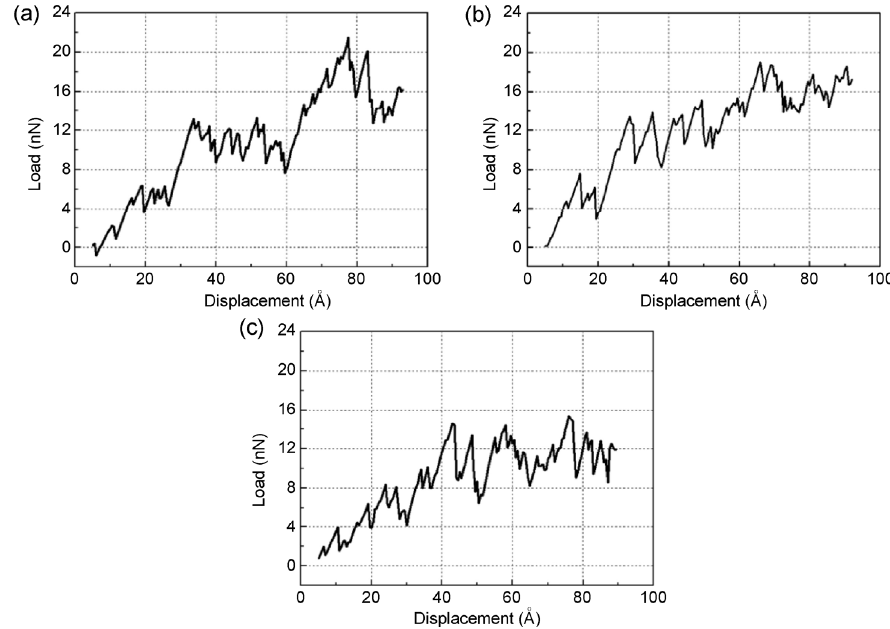
Fig. 10 Load–displacement plots with particle radius of (a) 5 nm, (b) 10 nm, and (c) 20